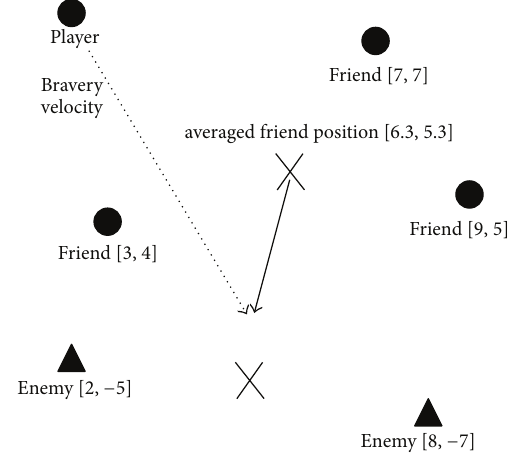
Figure 4: Bravery velocity when friendly team is